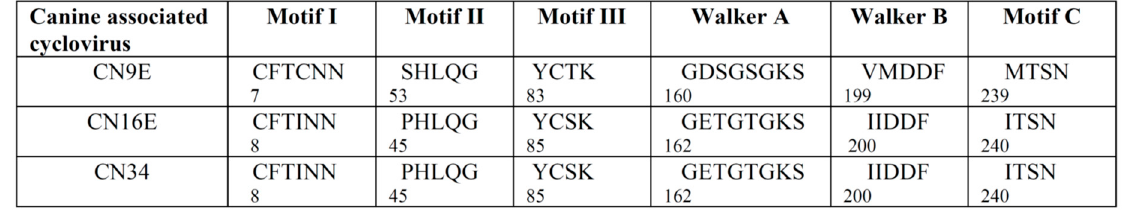
Figure 2. The conserved rolling circle replication (motifs I–III) and superfamily 3 helicase (Walkers A and B and motif C) motifs were retained in the putative replication-associated proteins (Rep) of the canine-associated cycloviruses. The number below the motif sequence corresponds to the position of the amino acid residue in the putative Rep protein.